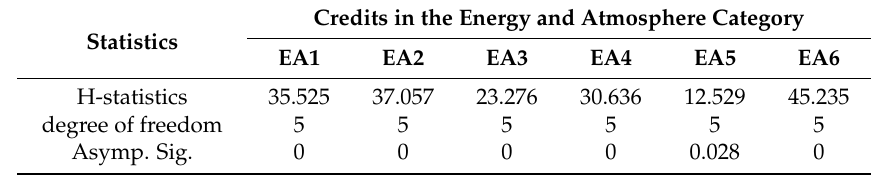
Table 6. Kruskal–Wallis test statistics of Energy and Atmosphere credits for building ownership.